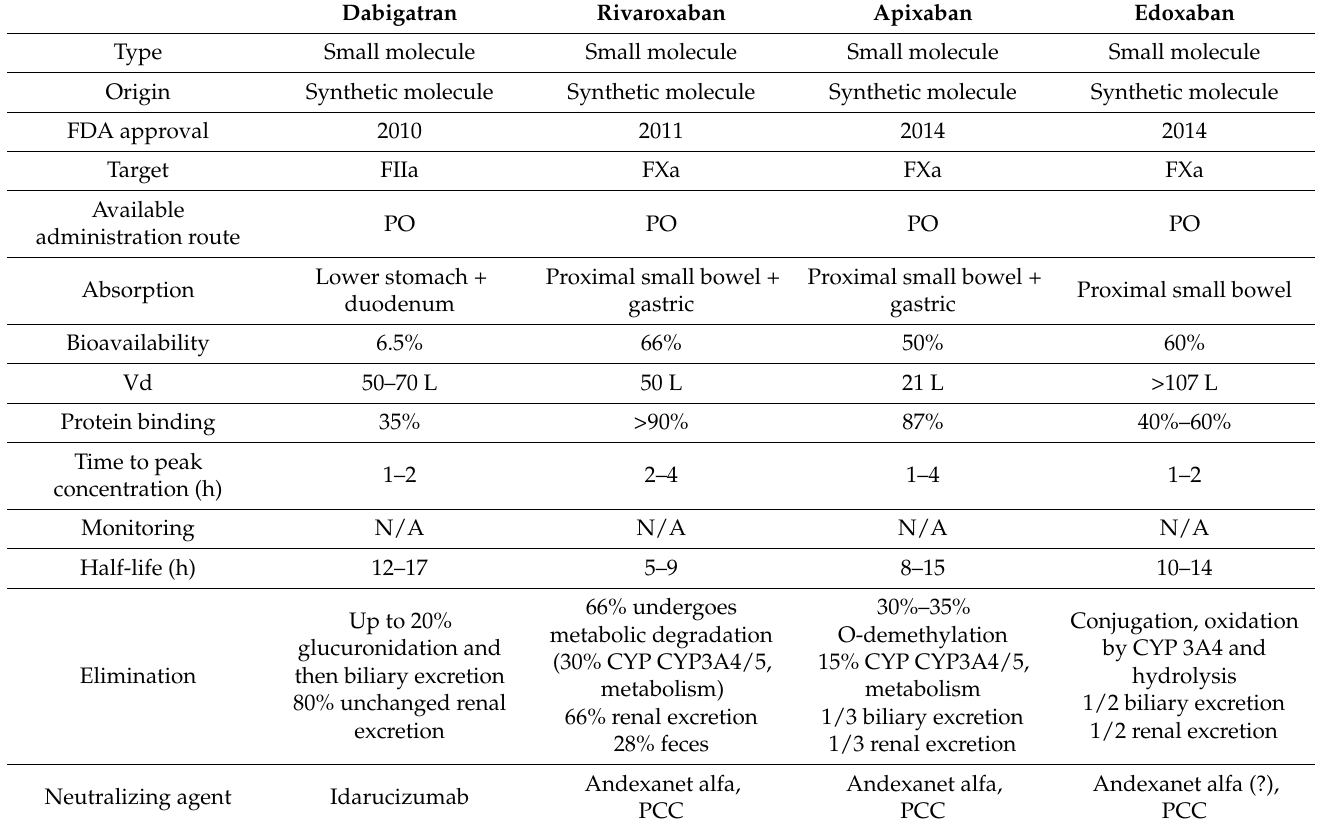
Table 4. Pharmacokinetics of dabigatran, rivaroxaban, apixaban, and edoxaban. Vd: volume of distribution, PO: per os (orally). PCC: prothrombin complex concentrates.